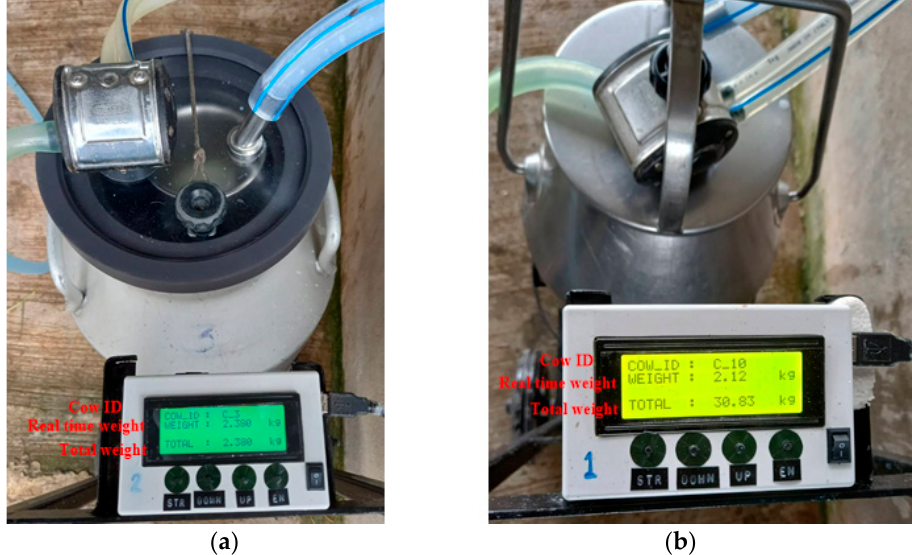
Figure 10. Milking stall used in experiments.